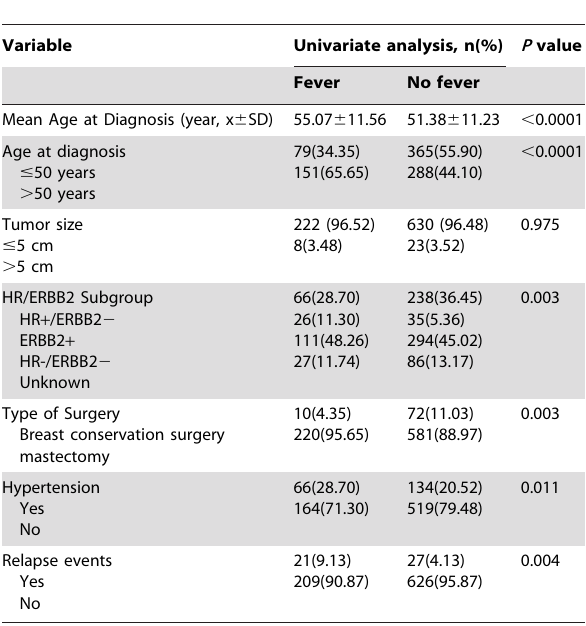
Table 1. Summary of patient’s characteristics and its association with postoperative fever.